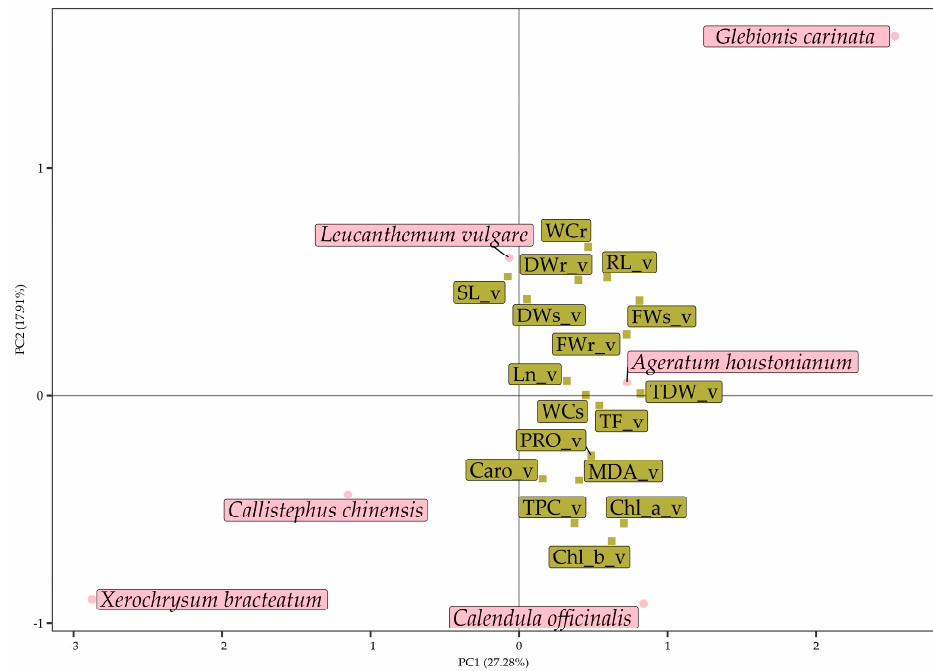
Figure 10. PCAsws biplot. Pink circles indicate the barycentres of the six studied species, whereas the green squares represent the 17 measured traits under severe water stress conditions (i.e., no drought stress). Abbreviations: shoot fresh weight (FWs), shoot dry weight (DWs), root fresh weight (FWr), root dry weight (DWr), total dry weight (TDW), shoot water content (WCs), root water content (WCr), shoot length (SL), root length (RL), leaf number (Ln), chlorophyll a (Chl a), chlorophyll b (Chl b), carotenoids (Caro), proline (PRO), total flavonoids (TF), total phenolic compounds